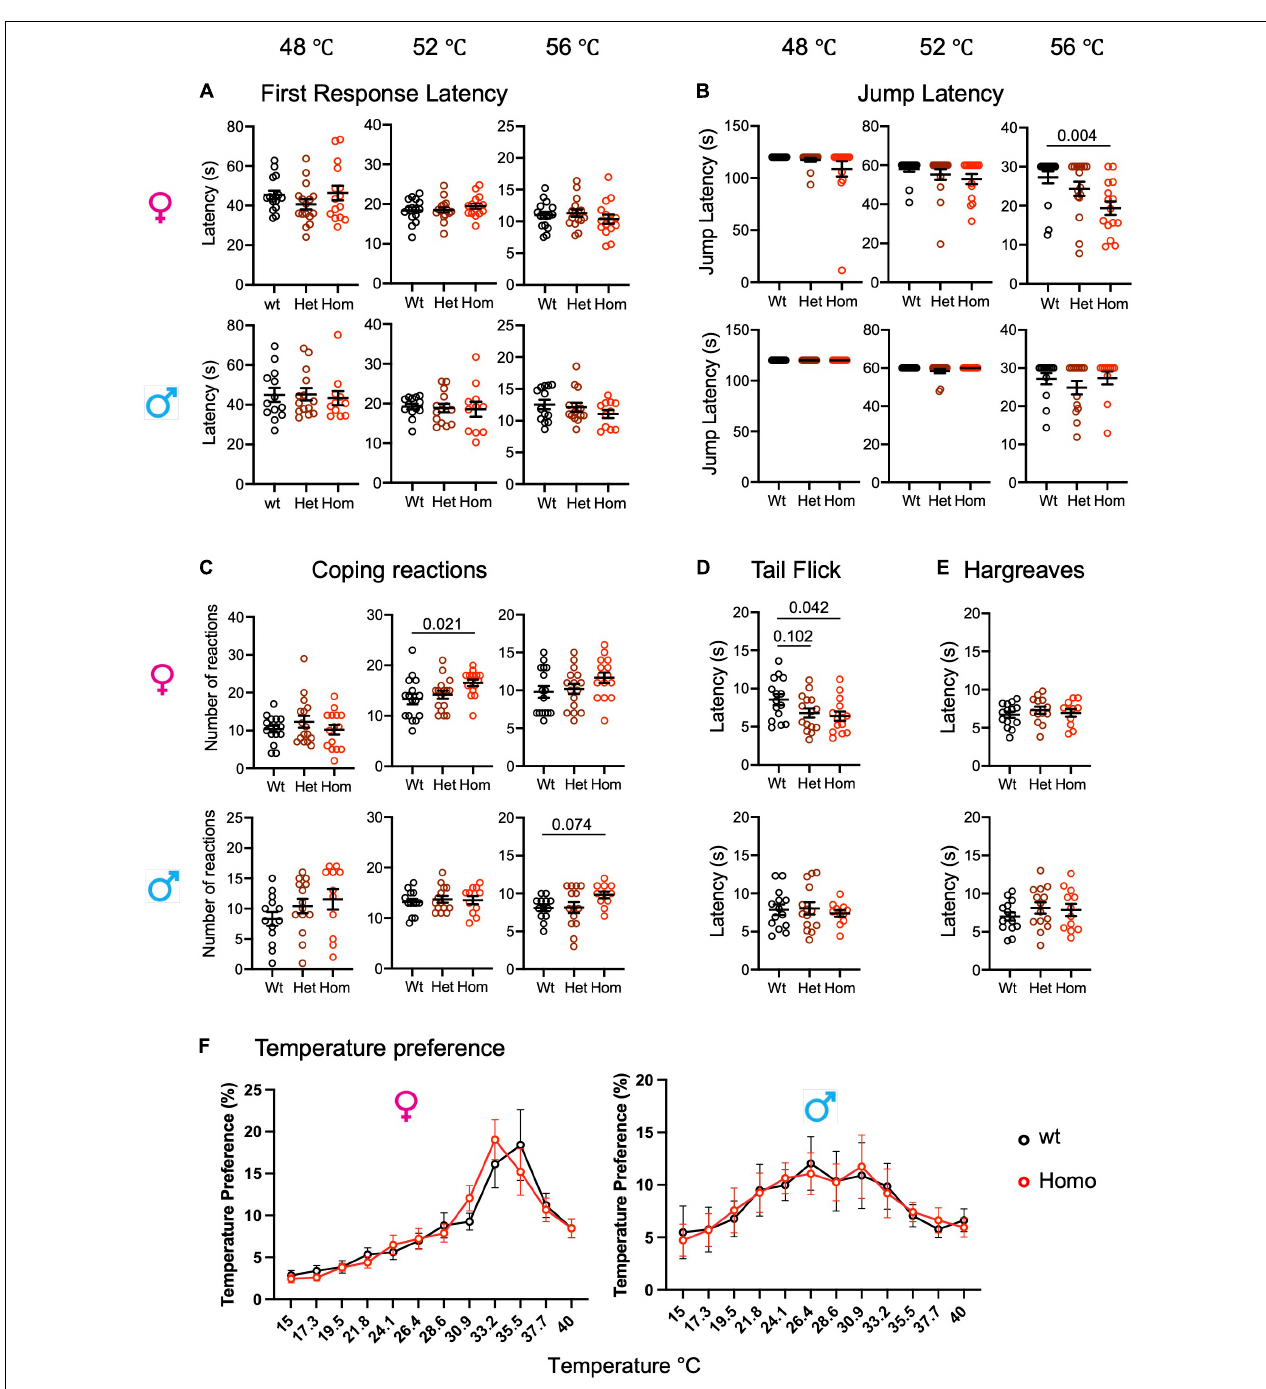
FIGURE 3 | Enhanced heat pain sensitivity in Scn9a R 185 H mice. (A) Wild-type and Scn9a R 185 H mice showed comparable first response latency on the hot plate. (B) Homozygous Scn9a R 185 H females had decreased jump latency in 56 ◦ C Hot Plate. (C) Homozygous Scn9a R 185 H female mice showed more coping reactions on the 52 ◦ C hot plate. (D) Heterozygous and homozygous Scn9a R 185 H females had lower tail latency in the tail flick test. (E) No difference was found between wt and mutant mice in the Hargreaves test. (F) Control wt and mutant mice showed the same temperature preference. Results are shown as means ± SEM. Hot plate, females: wt, n = 16; Het, n = 16; Homo, n = 15; males: wt, n = 13; Het, n = 14; Homo, n = 11. Tail flick: females: wt, n = 15; Het, n = 15; Homo, n = 14; males: wt, n = 14; Het, n = 14; Homo, n = 11. Hargreaves: females: wt, n = 14; Het, n = 13; Homo, n = 11; males: wt, n = 14; Het, n = 14; Homo, n = 11. Temperature preference: females: wt, n = 12; Homo, n = 12; males: wt, n = 11; Homo, n = 11. One-way ANOVA on females and males and Dunnett’s multiple comparison tests for hot plate, tail flick, and Hargreaves tests; two-way ANOVA for the thermal preference ring test. P -values for genotype difference are shown when significant or close to significance. See Supplementary Tables 7–9 for